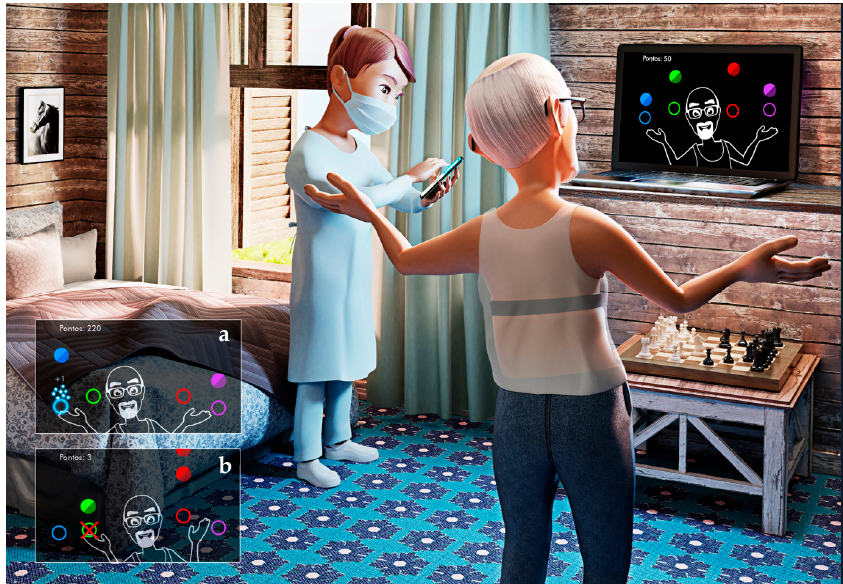
Figure 1. Representative design of the accomplishment of the MoveHero activity in the use of the webcam interface. ( a ) Demonstration of hit performed by the participant. ( b ) Miss performed by the participant.